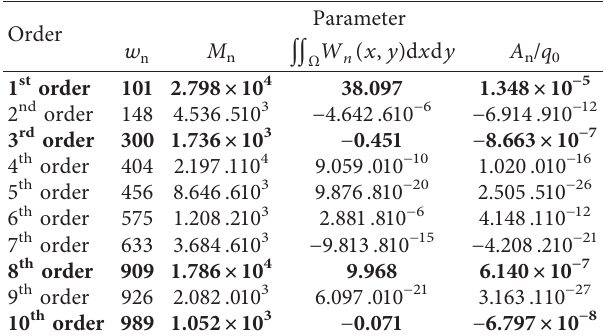
Table 3: The first 10 order vibration parameter values of the thin plate rock mass under impact load